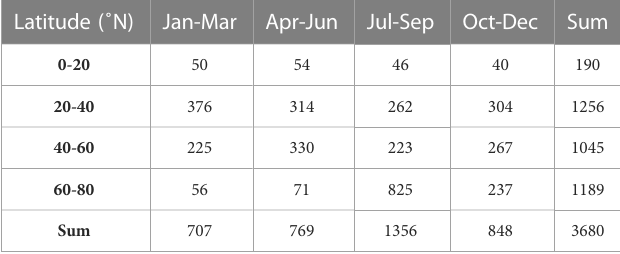
The number of pro fi les are shown for each three month period and 20 degree latitude band.